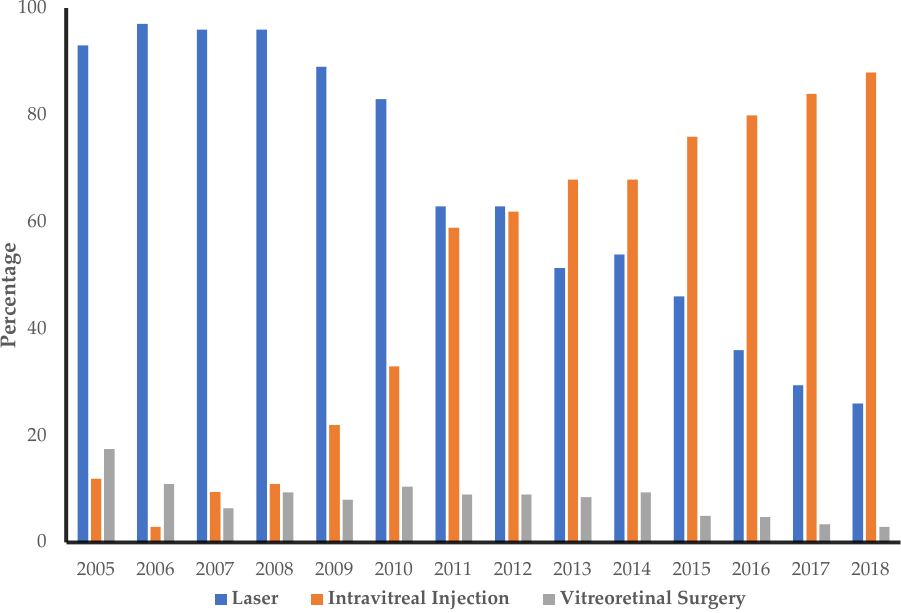
Figure 2. Average percentage of treatments for diabetic retinopathy in patients receiving laser, intravitreal injection and/or vitreoretinal surgery.